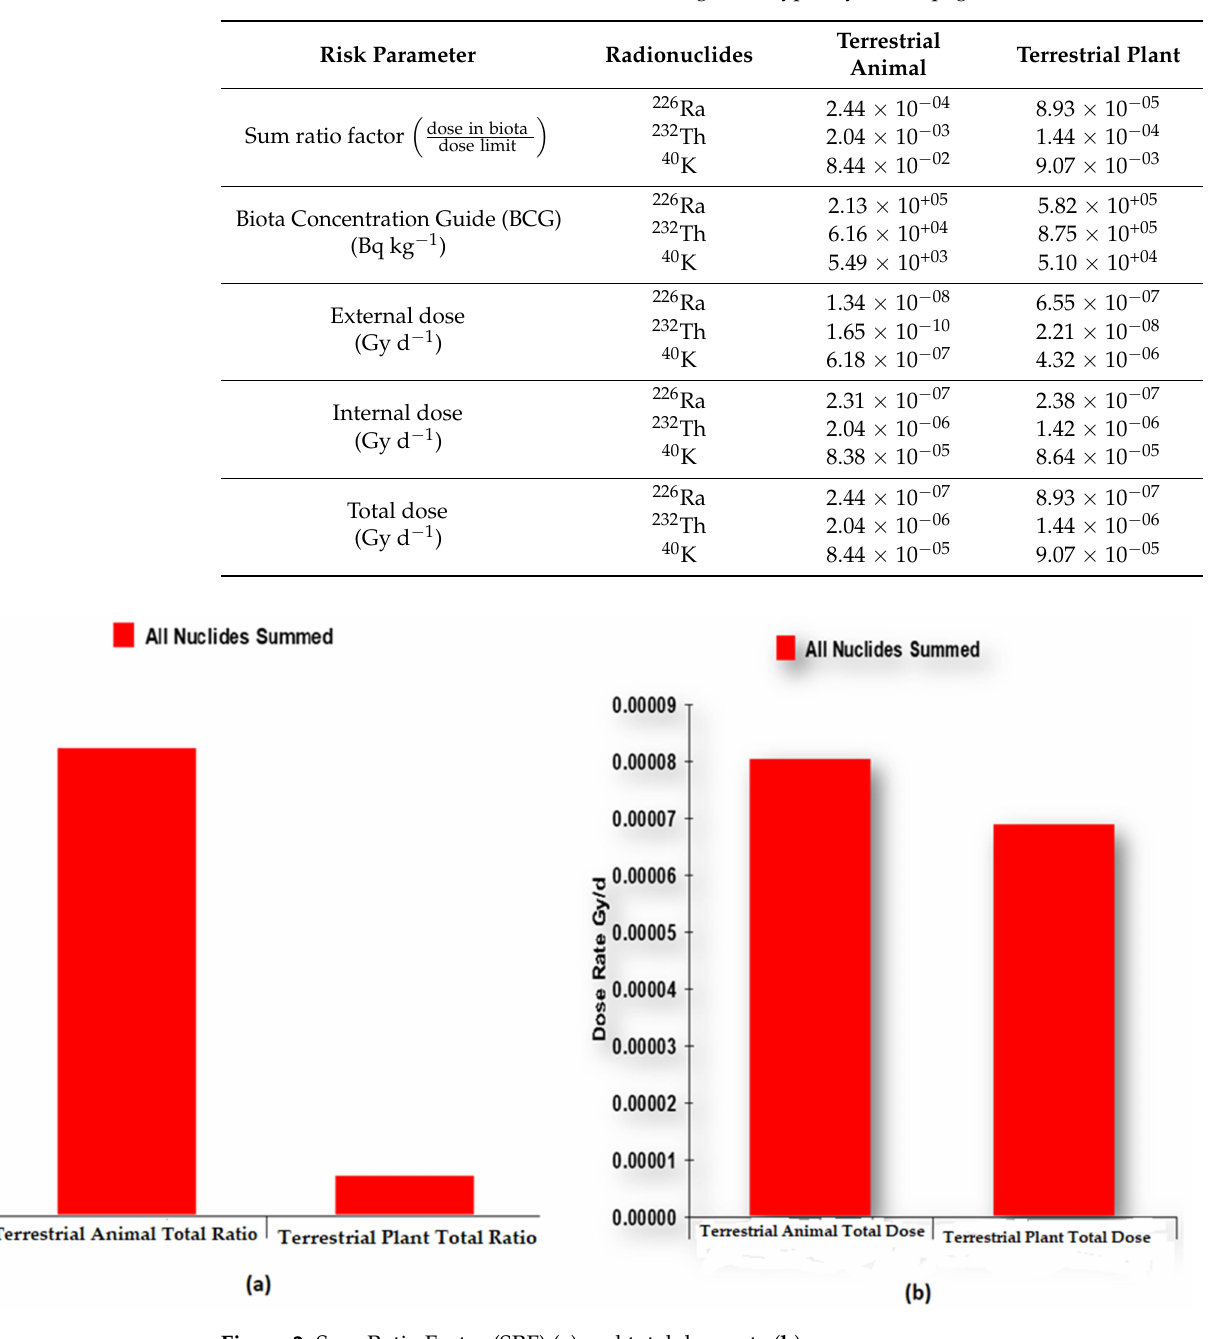
Table 4. The biota concentration guide (BCG), sum ratio factor (SRF), internal dose, external dose, and total dose of 226 Ra, 232 Th, and 40 K in two organism types by soil (Bq kg − 1 ) media. Risk Parameter Radionuclides